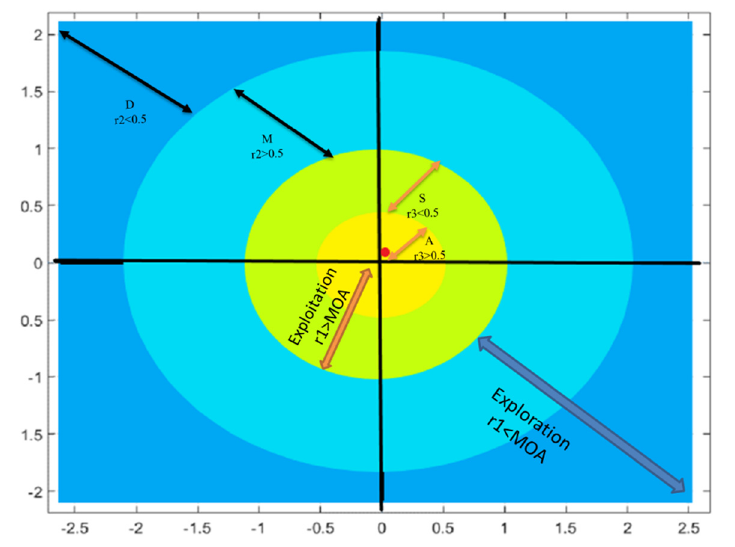
Figure 1: Exploratory and exploitative phases of AOA [ 9 ]